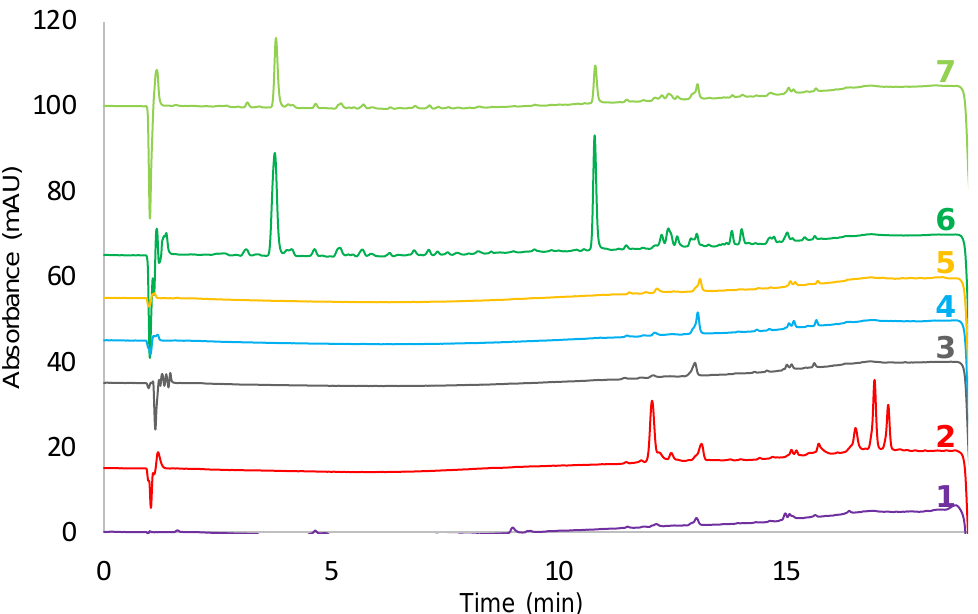
Figure 1. Chromatograms recorded at 280 nm (method A) corresponding to the extraction of a turmeric sample ( Curcuma longa , Erode var.). Extraction conditions: A total of 5 mg of sample; 10 mL solvent; 40 min extraction time with ultrasound-assisted extraction (UAE). Separation conditions: Kinetex column; elution gradient 5% to 90% MeOH in 15 min. Solvent assignment: 1 = CH 2 Cl 2 ; 2 = acetonitrile (ACN); 3 = EtOH; 4 = MeOH; 5 = MeOH/water (1/1, v/v ); 6 = DMSO; 7 = DMSO/water (1/1, v/v ).